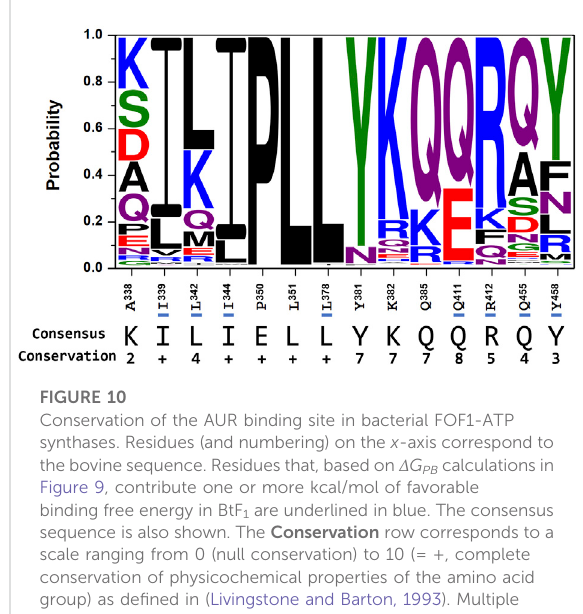
FIGURE 10 Conservation of the AUR binding site in bacterial FOF1-ATP synthases. Residues (and numbering) on the x -axis correspond to the bovine sequence. Residues that, based on Δ G PB calculations in Figure 9, contribute one or more kcal/mol of favorable binding free energy in BtF 1 are underlined in blue. The consensus sequence is also shown. The Conservation row corresponds to a scale ranging from 0 (null conservation) to 10 (= +, complete conservation of physicochemical properties of the amino acid group) as de fi ned in (Livingstone and Barton, 1993). Multiple sequence alignment of 23,125 entries was performed with Clustal Omega (Sievers et al., 2011). Logos were generated using the Weblogo3 server (Crooks et al.,